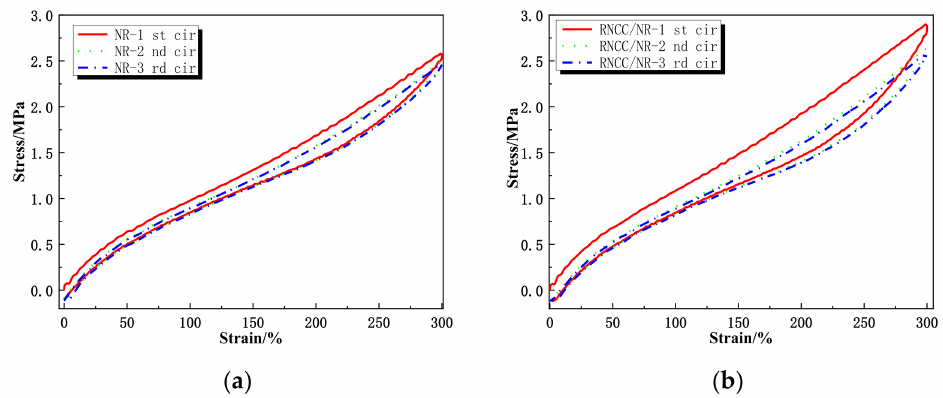
Figure 6. Mullins effect of the NR and RRC/NR samples. ( a ) Mullins effect of NR; ( b ) Mullins effect of